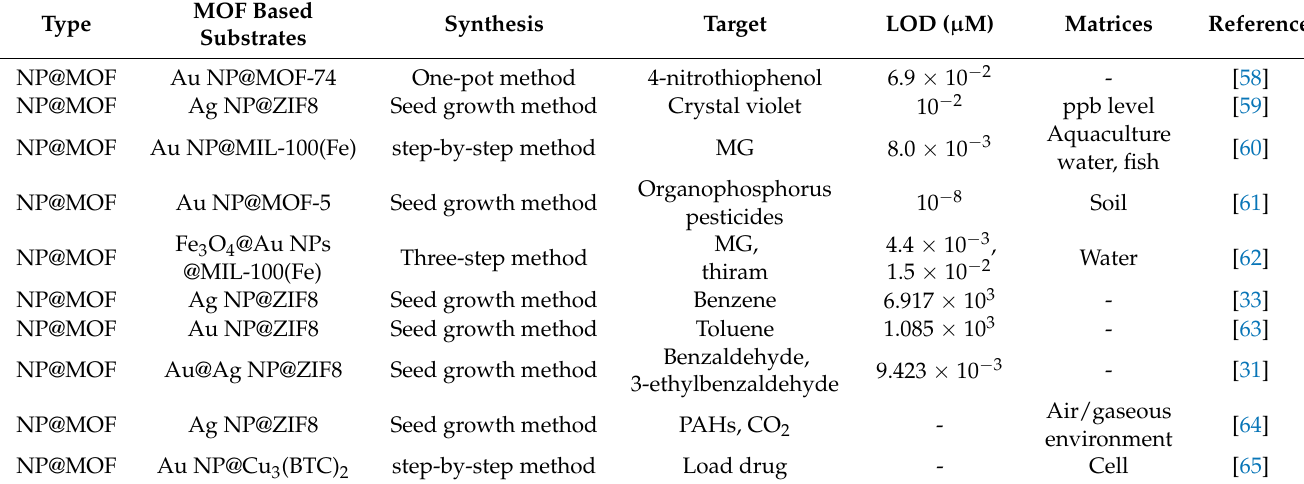
Table 3. Application of SERS-active NP encapsulated in MOF composites in SERS